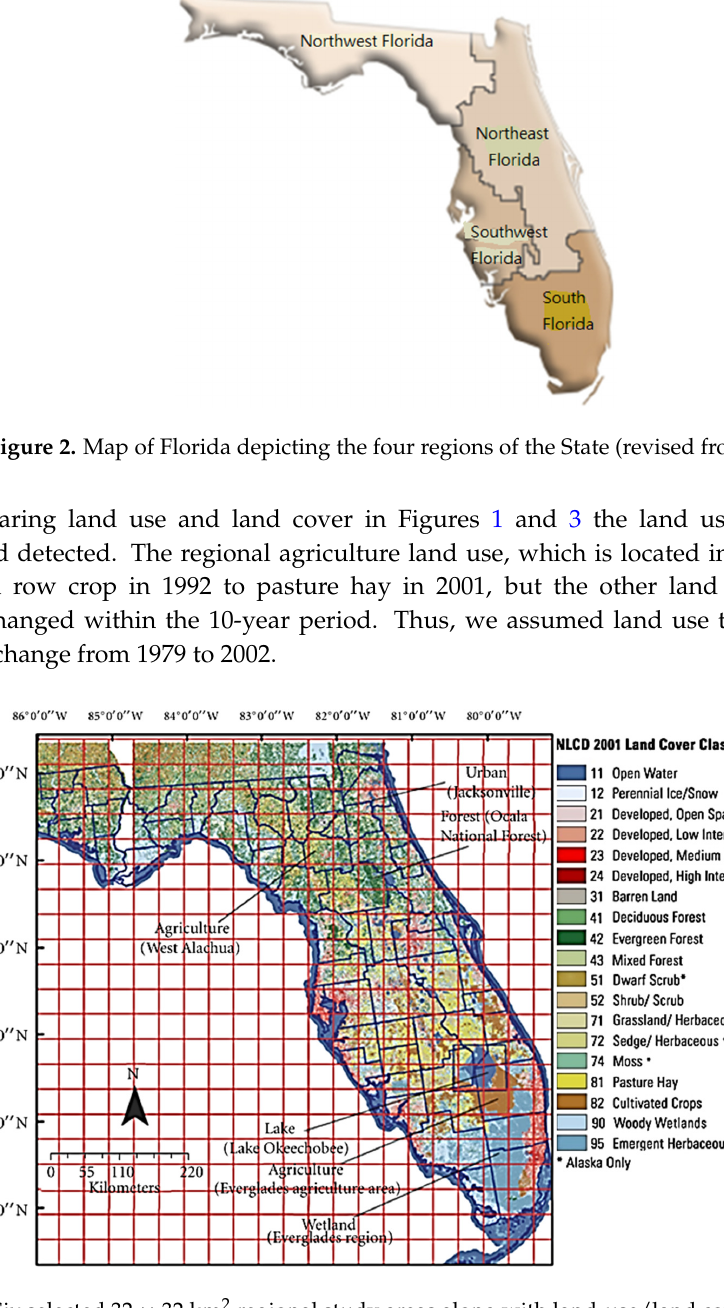
Figure 3. Six selected 32 × 32 km 2 regional study areas along with land-use/land cover from the 2001 National Land Cover Dataset. The red gridline is a 32 × 32 km 2 resolution grid from NARR Data reanalysis dataset (revised from [34]).